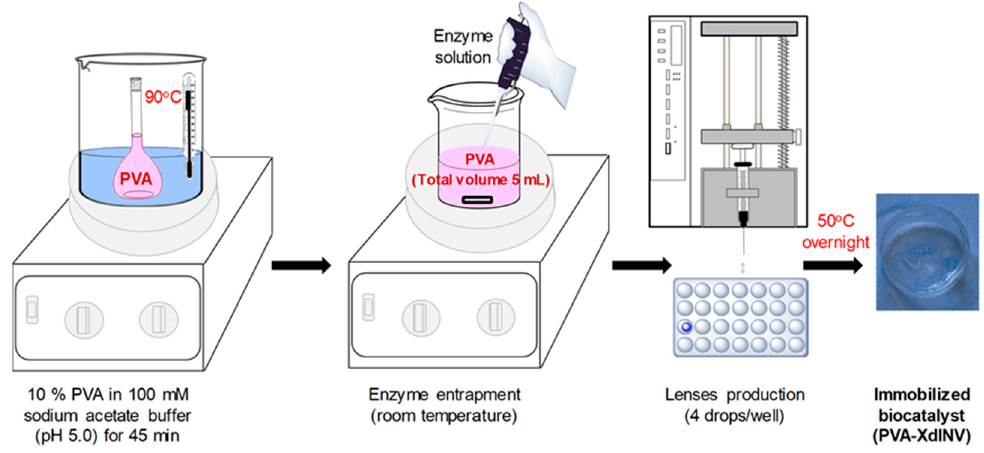
Figure 1. Immobilization of pXd-INV by entrapment in polyvinyl alcohol (PVA). Table 1. Effect of pXd-INV enzyme loading on the activity and recovery upon immobilization by entrapment in PVA hydrogels.